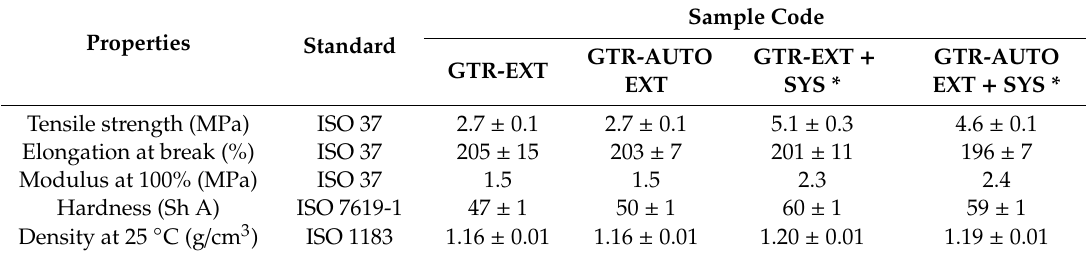
Table 8. Physico-mechanical properties of GTR-EXT and GTR-AUTO-EXT with and without a sulfur curing